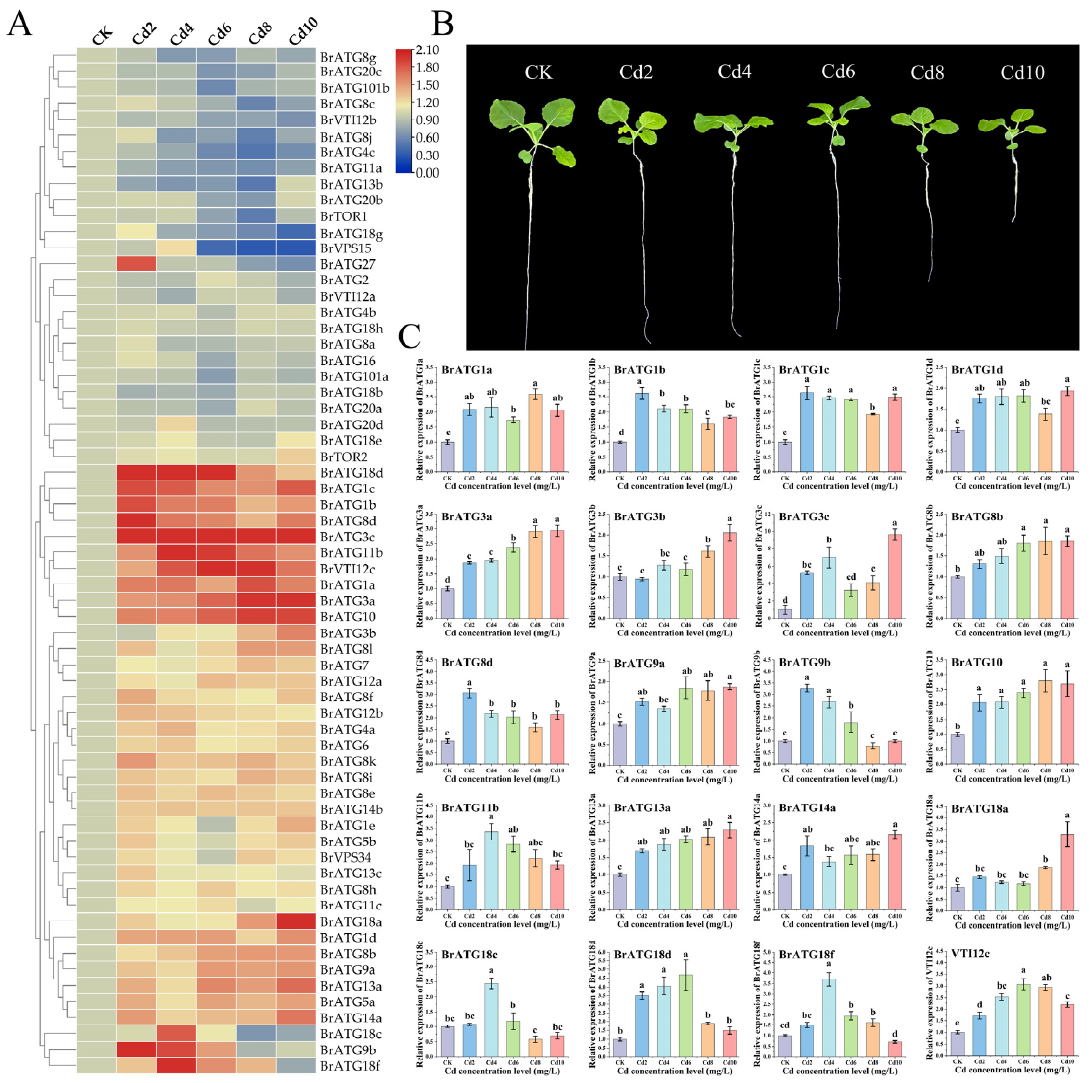
Figure 7. Analysis of BrATG gene expression profile under different levels of cadmium (Cd) stress.